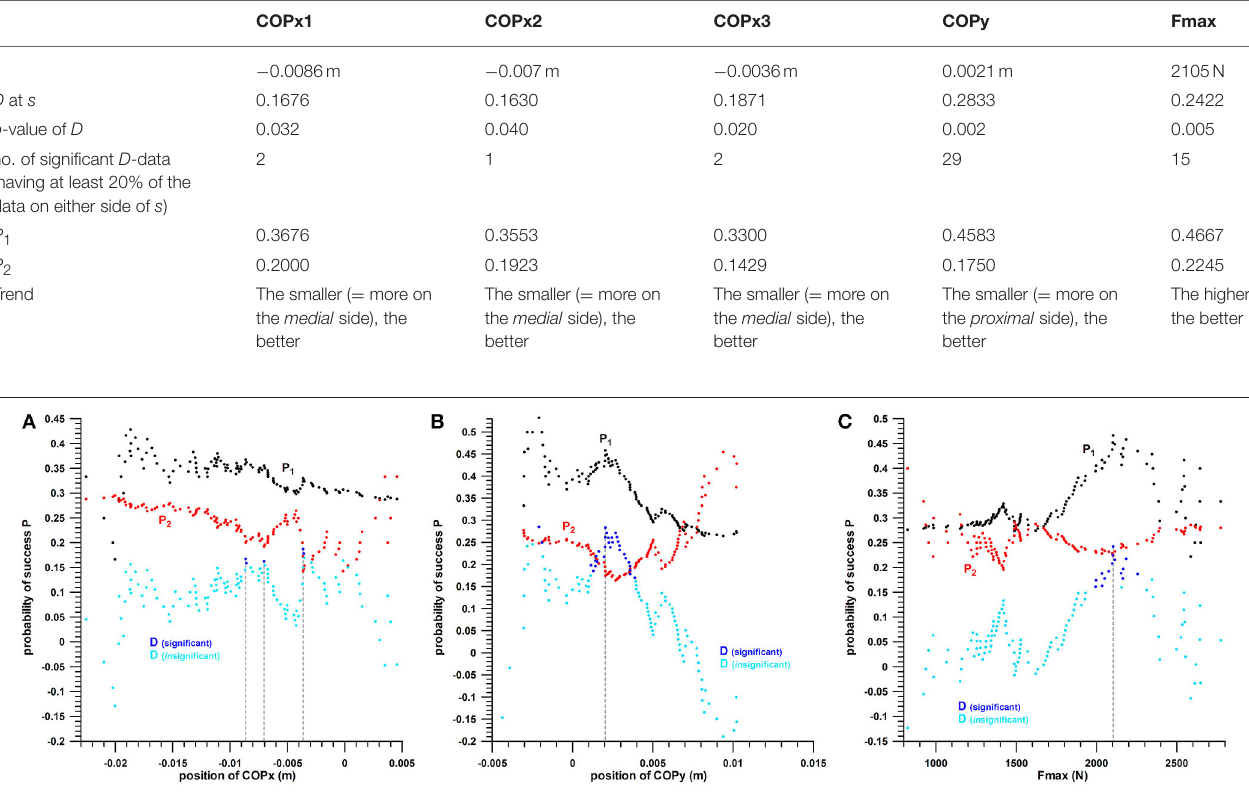
TABLE 1 | Summary of trend analyses; s = parameter value at the separation line, separating the favorable parameter range from the unfavorable one; D = differential of P 1 (probability of scoring a goal if the parameter is in the favorable range) and P 2 (probability of scoring a goal if the parameter is in the unfavorable range); COPx, center of pressure in x-direction; COPy, center of pressure in y-direction; Fmax, maximum impact force.